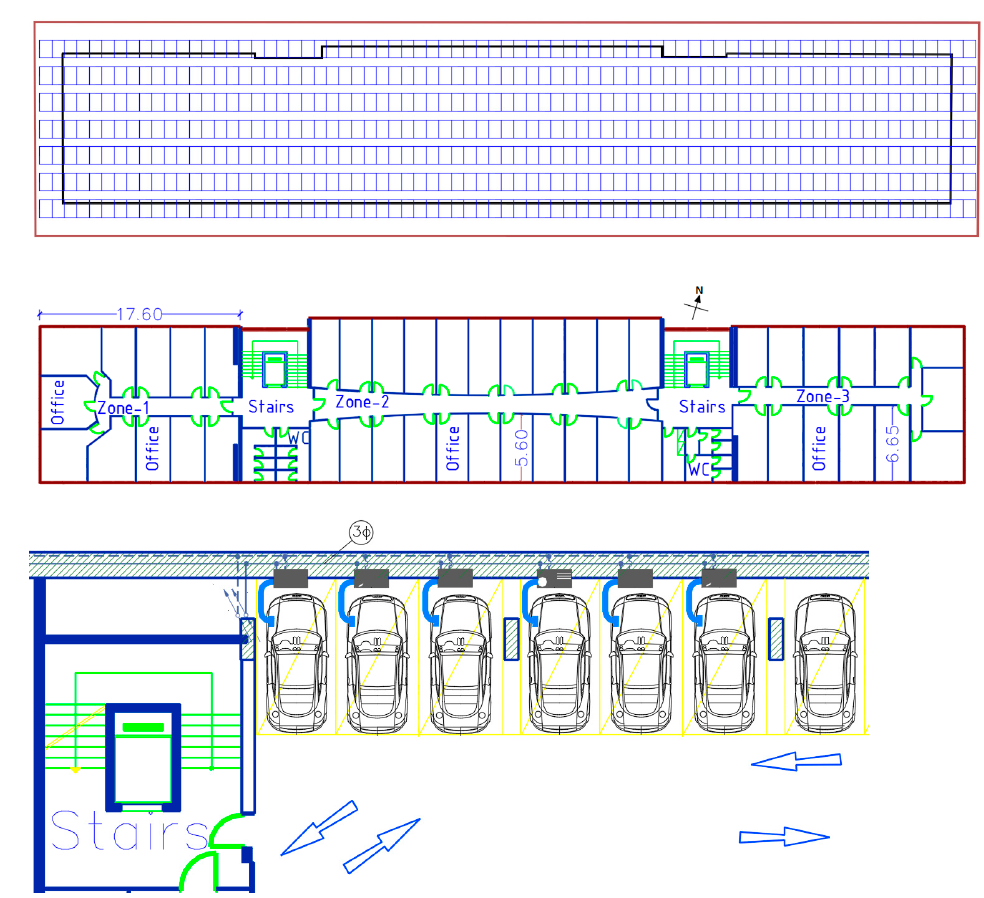
Figure 1. Layout drawing of the building’s rooftop PV installation; a typical fl oor level and a